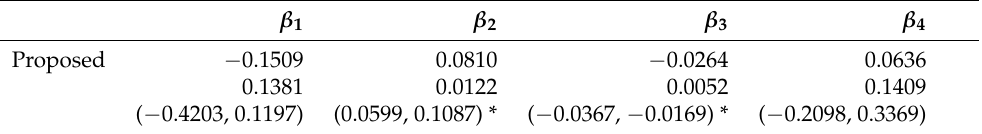
Table A5. Estimation results (posterior mean, posterior standard deviation and 95% credible interval) of the covariate effects when common covariate effects are assumed for the two types of skin cancers from the proposed method, He et al. (2008)’s method, and Zhang et al. (2013)’s method. * indicates statistically